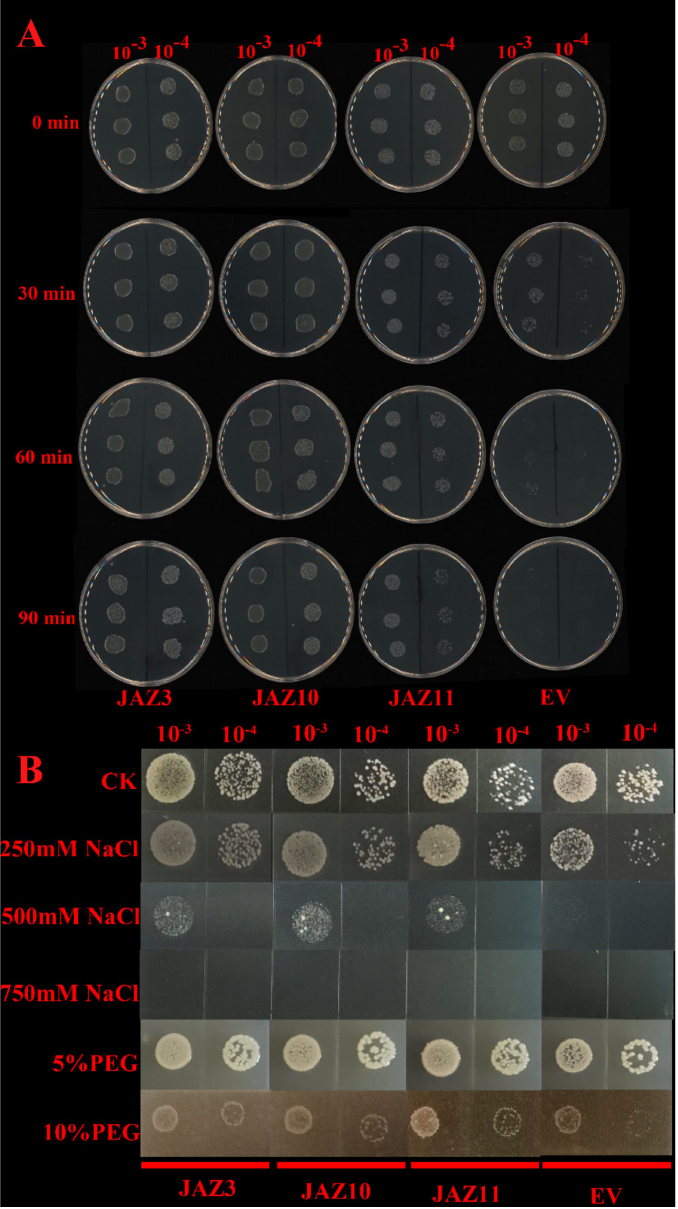
Figure 7. ( A ) Spot assay of BL21(DE) / pGEX-4T-1–CsJAZ3, pGEX-4T-1–CsJAZ10, and pGEX-4T-1– CsJAZ11 and BL21(DE) / pGEX-4T-1 (EV) on LB plates after the cell mediums were treated with 55 ◦ C for 0, 30, 60, and 90 min. ( B ) Spot assay of BL21(DE) / pGEX-4T-1–CsJAZ3, pGEX-4T-1–CsJAZ10, and pGEX-4T-1–CsJAZ11, and BL21(DE) / pGEX-4T-1 (EV) on LB plates with NaCl and